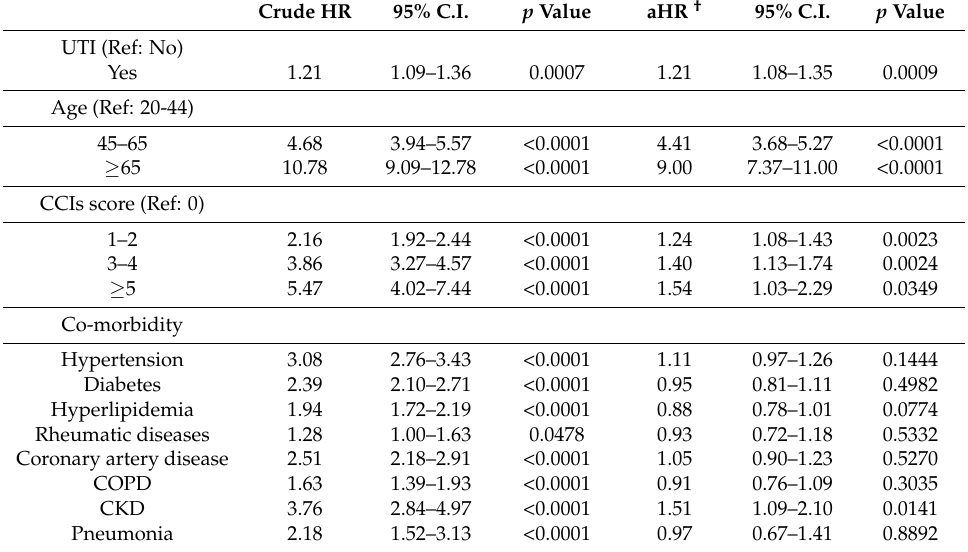
Table 4. Adjusted hazard ratio of all cancer in Female.